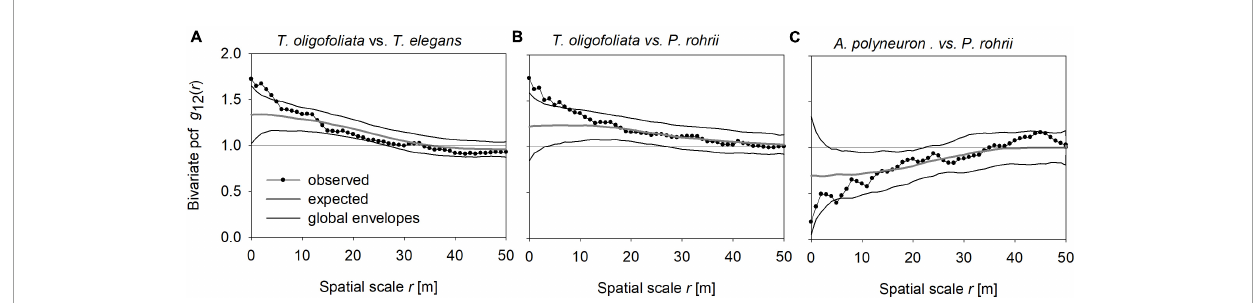
FIGURE5 Examples of significant small-scale species interactions: (A) T. oligofoliata vs. T. elegans ; (B) T. oligofoliata vs. P. rohrii ; (C) A. polyneuron vs. P. rohrii . Shown are the observed pair-correlation function g 12 ( r ) in dependence of spatial scale r (dotted line), the global simulation envelopes (solid lines) and the expected g function of the heterogeneous Poisson process null model (gray line; average of the simulation of null-model). The horizontal lines give the expected g 12 ( r ) = 1 for no species interactions. The heterogeneous Poisson point process used with a bandwidth R = 30 m, and the ring width dr for the estimation of the pair-correlation function was 3